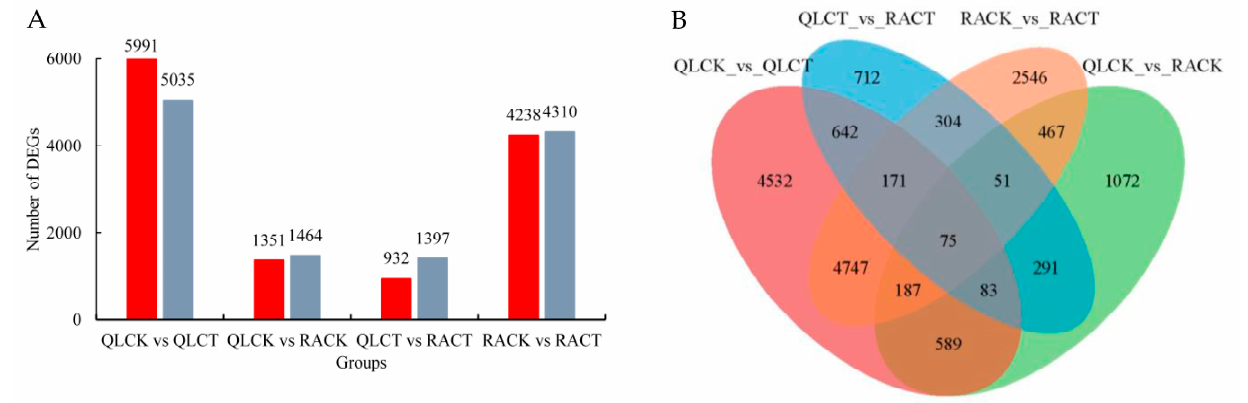
Figure 4. Differentially expressed genes in QLCK vs. QLCT, QLCK vs. RACK, QLCT vs. RACT, and RACK vs. RACT comparisons. ( A ) The graph represents the number of up- and downregulated genes in different comparisons. The upregulated and downregulated genes are shown in red and in grey, respectively. ( B ) Venn diagram for DEGs identified in different comparisons. The numbers represent the quantity of DEGs obtained in each category. Table 3. KEGG enrichment analysis based on DEGs in the comparison of QLCK vs. QLCT.